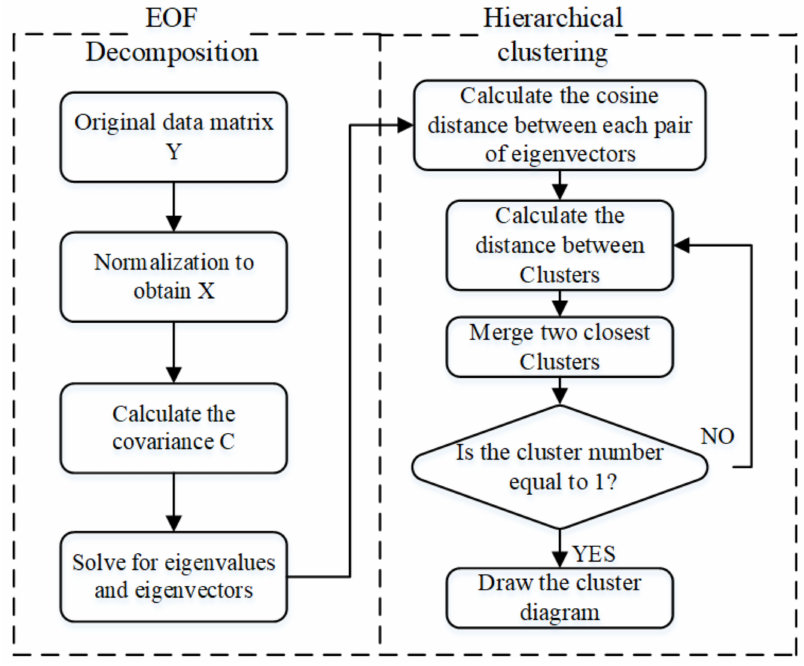
Figure 1. Flow chart of the sub-region division